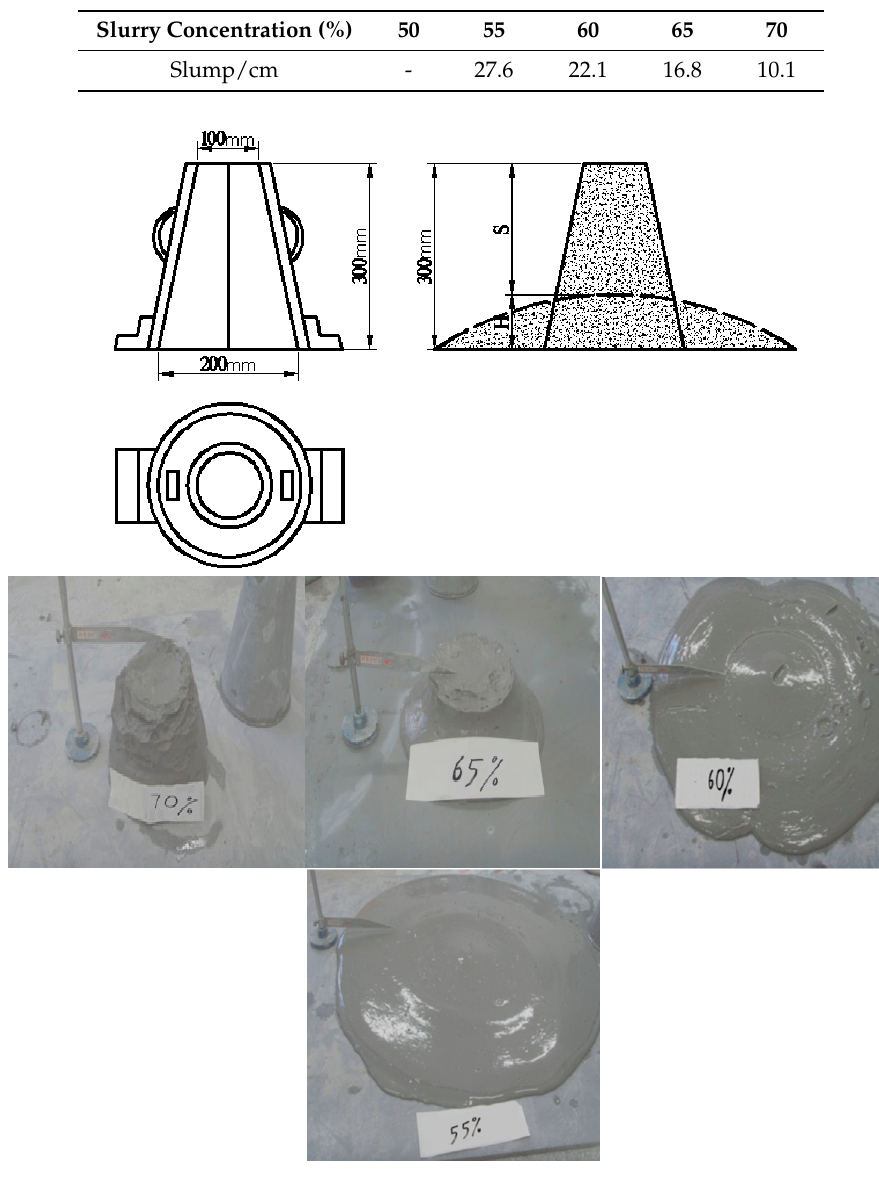
Figure 12. Backfill slurry slump test.